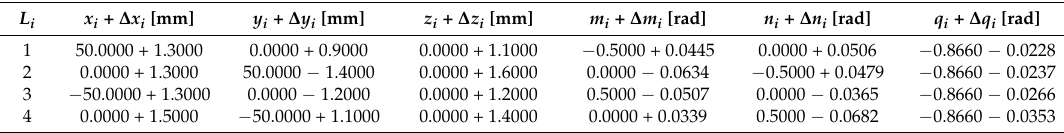
Table 2. The assumptive nominal sensor parameters and corresponding parameter